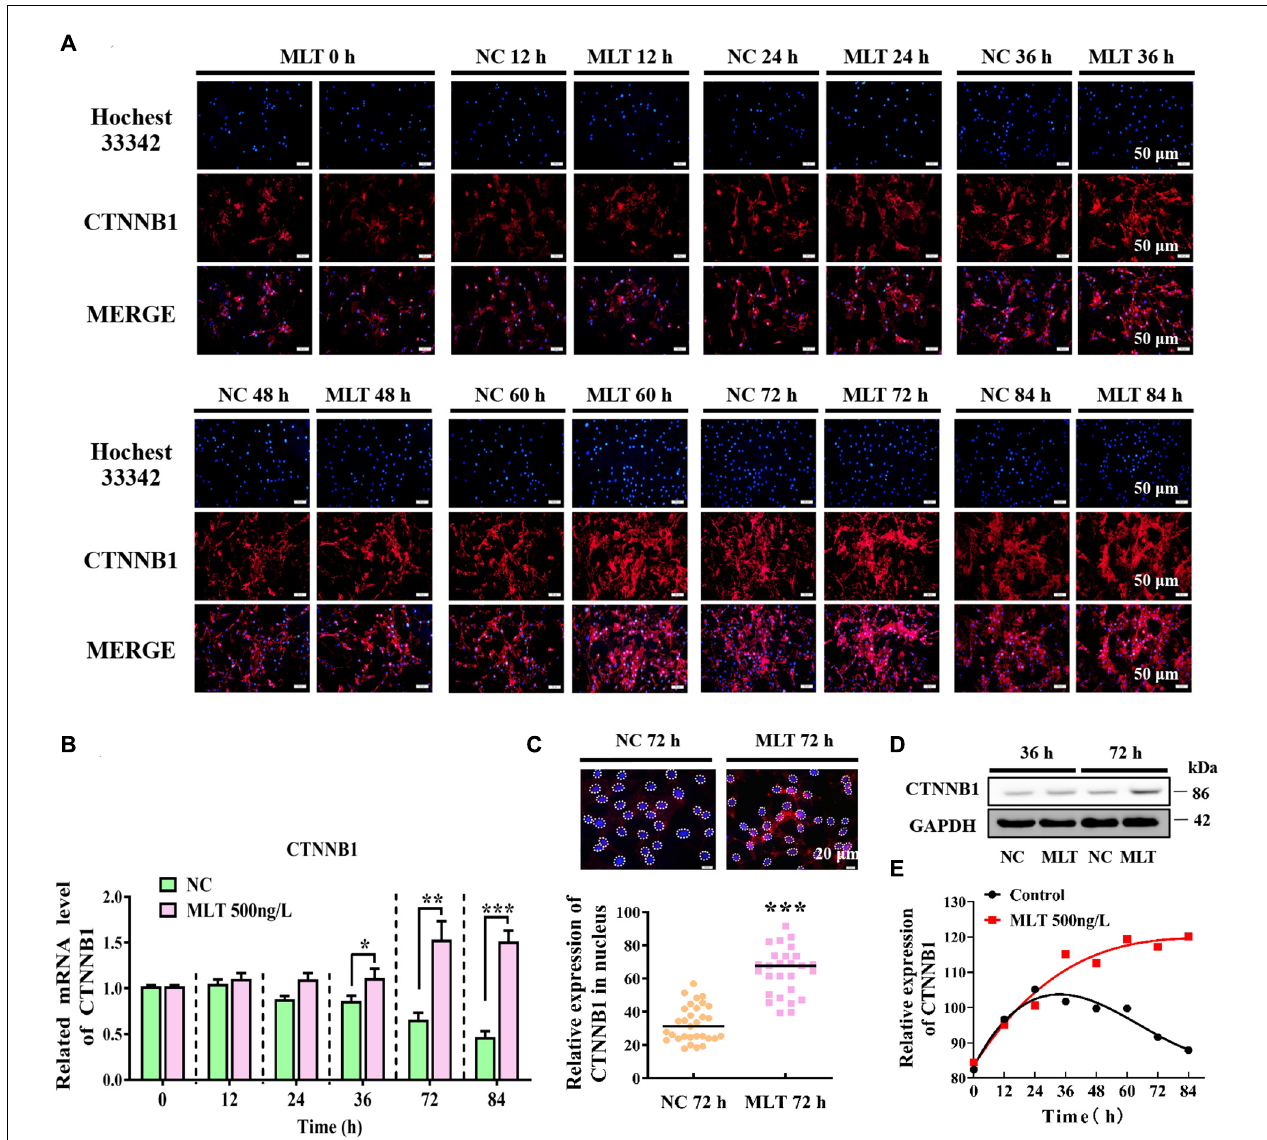
FIGURE 2 | Melatonin maintained the continuous activation of Wnt signaling in gsHFSCs. (A) CTNNB1, as detected by immunofluorescence staining after stimulation by different periods of melatonin exposure. Scale bar, 50 µ m. (B) Relative mRNA levels of CTNNB1 (Control: green; melatonin: pink); * p < 0.05, ** p < 0.01. (C) CTNNB1 marked by immunofluorescence in gsHFSCs. Scale bar, 20 µ m (white circles circumscribe the position of CTNNB1 in the nuclei), and relative immunofluorescence intensity of CTNNB1 in nuclei; *** p < 0.001. (D) Protein levels of CTNNB1 between 36 and 72 h in treated gsHFSCs as shown by Western blotting. (E) Fluorescence density analysis of CTNNB1 in the nuclei of gsHFSCs after stimulation with different periods of melatonin